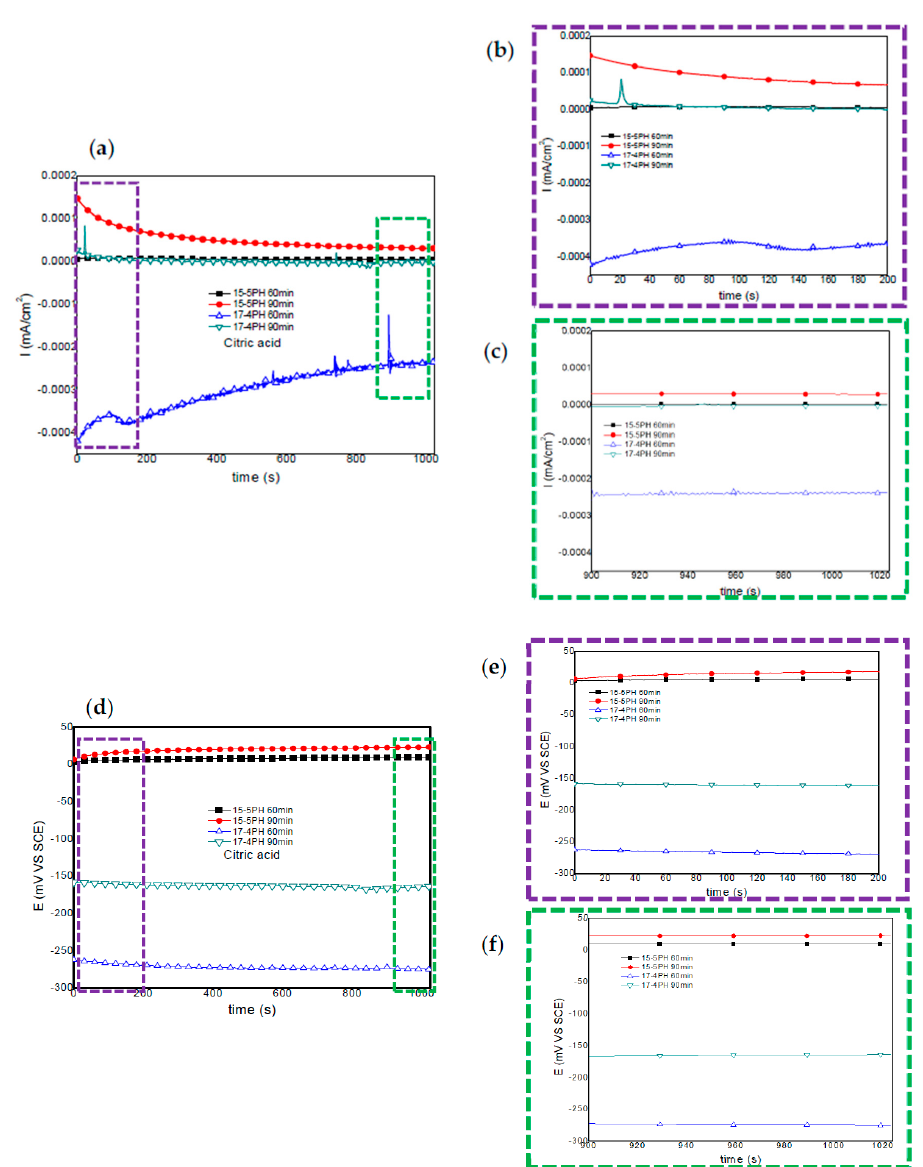
Figure 3. Electrochemical current and potential noise-time series for 15-5PH and 17-4PH samples passivated in citric acid at 49 °C, exposed in a 5 wt.% NaCl solution ( a , d ). Windowing of electrochemical current noise (ECN) from 0–200 and 900–1024 s ( b,c ); windowing of electrochemical potential noise (EPN) from 0–200 and 900–1024 s ( e , f ).